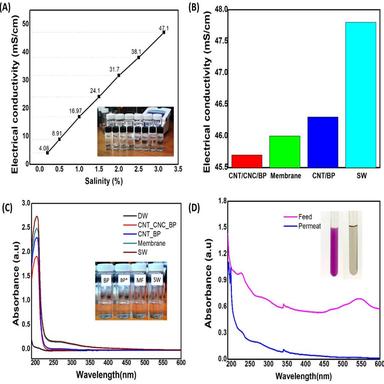
Filtration ability of CNT/CNC BP. (A) Salinity vs electrical conductivity (B) electrical conductivity of feed and filtrate water, (C) absorbance spectra of feed and filtrate water. (D) Absorbance spectra of feed (dye) and permeate solution. (For interpretation of the references to color in this figure, the reader is referred to the web version of this article.)